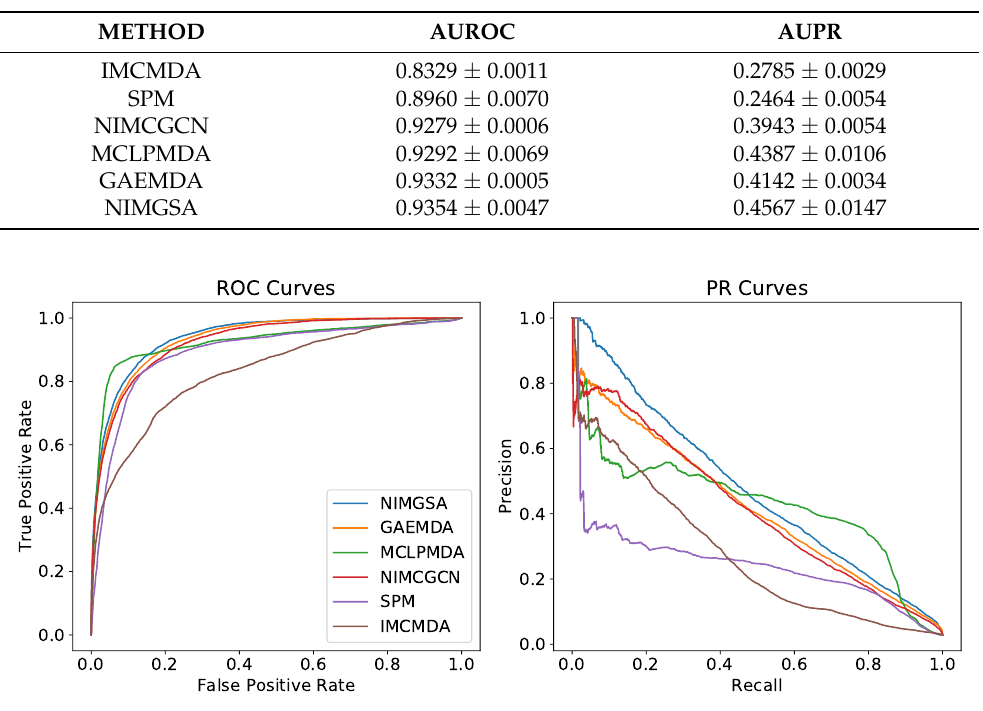
Table 1. Mean values and standard deviations of AUROC and AUPR, compared with differ- ent methods.